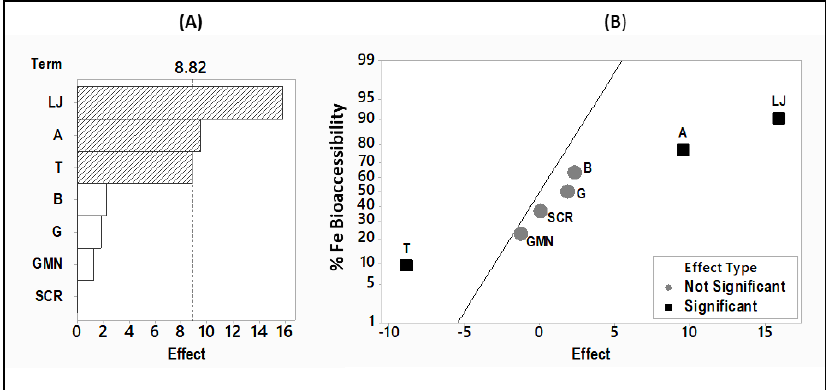
Figure 2. Pareto chart ( A ) and the Normal plot ( B ) of the e ff ects of the seven factors of processing and formulation on iron bioaccessibility in the HDPF samples according to the Hadamard matrix, circular permutation by the right ( α = 0.05). (HDPF: hummus with di ff erent processing and formulation).